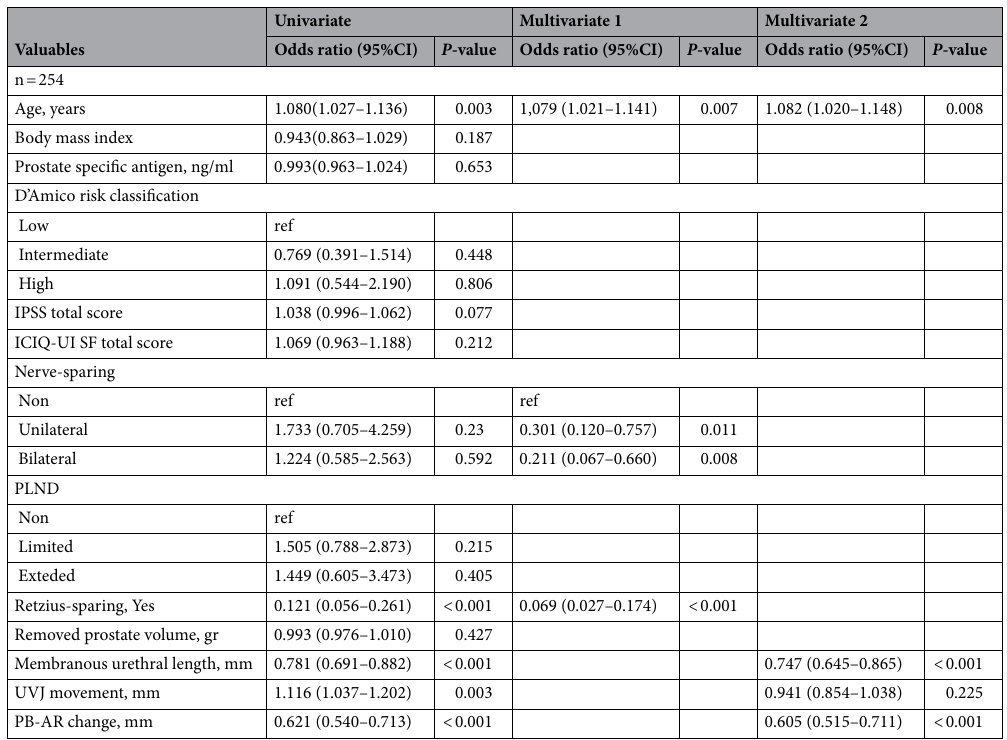
Table 2. Univariate and multivariate logistic regression analysis of urine loss ratio after robot-assisted radical prostatectomy. CI confidence interval, ICIQ-UI SF International Consultation on Incontinence Questionnaire- Urinary Incontinence Short Form, IPSS International prostate symptom score, PB-AR distance from pubic bone to anterior rectum, PLND pelvic lymphnode dissection, UVJ urethrovesical